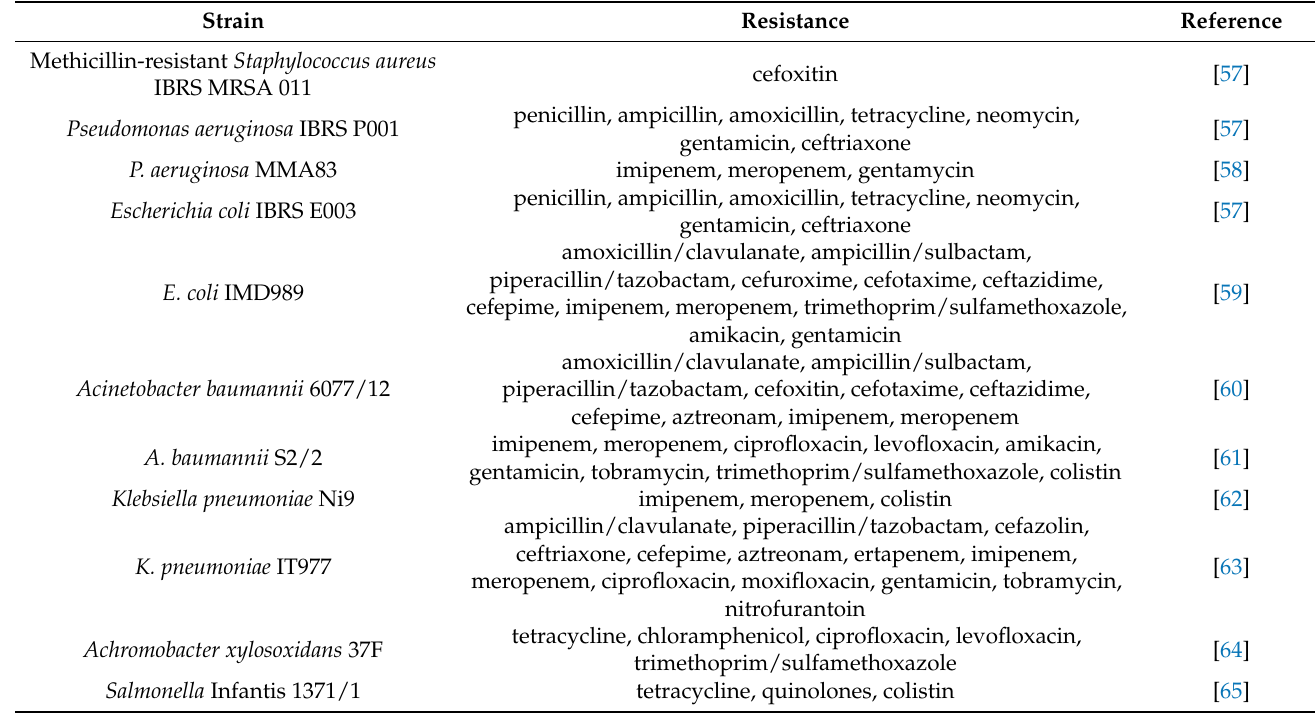
Table 3. List of bacterial strains used in the study and the corresponding antibiotic resistance. Strain